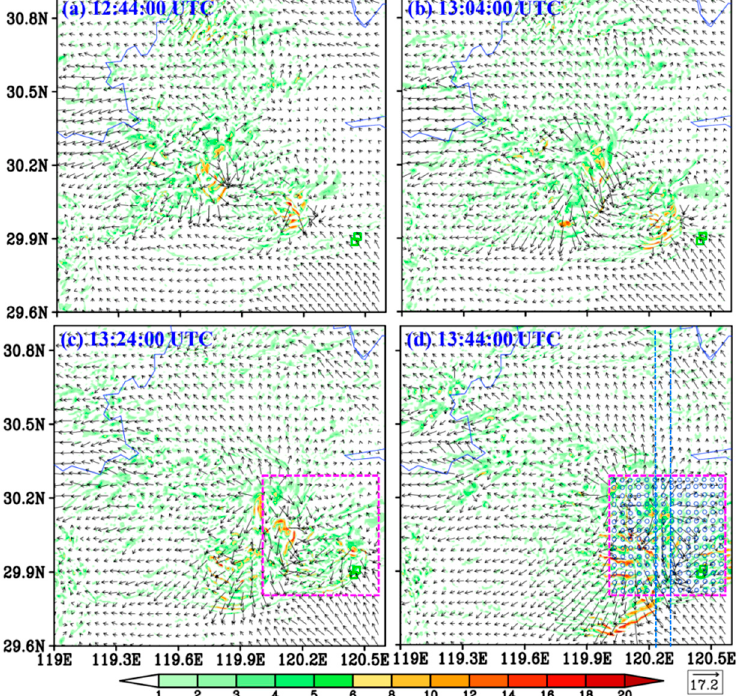
Figure 8. Panels ( a – d ) show the simulated surface wind vector (arrows; m s − 1 ) and its divergence (shading; 10 − 3 s − 1 ) at typical stages of the event. The dashed purple box marks the regions where the downburst appeared, the small blue open circles show the locations for backward tracking, the small green boxes mark the locations at which the tower toppling appeared, and the two dashed lines mark the band (from 120.24° E to 120.32° E) for calculating the averaged cross section.